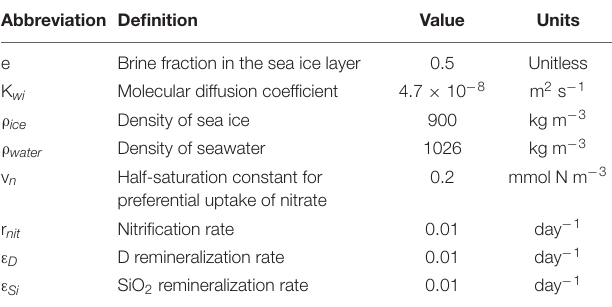
TABLE 2 | List of parameters, corresponding description, and units used in the model for nutrients